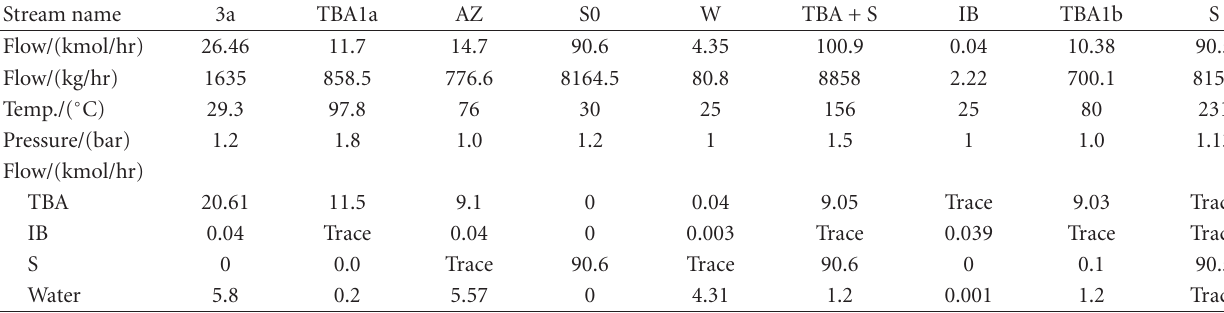
Table 4: Stream results for the azeotrope separation section (Figure 8).